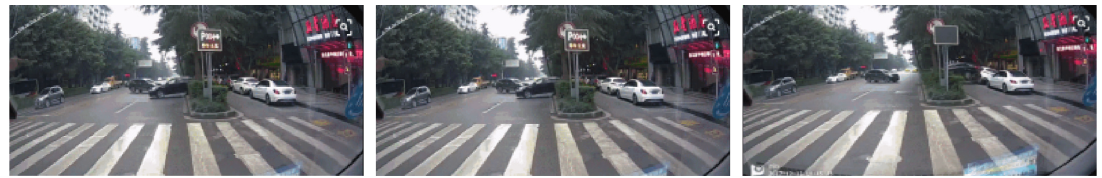
Figure 16: Original video frame.